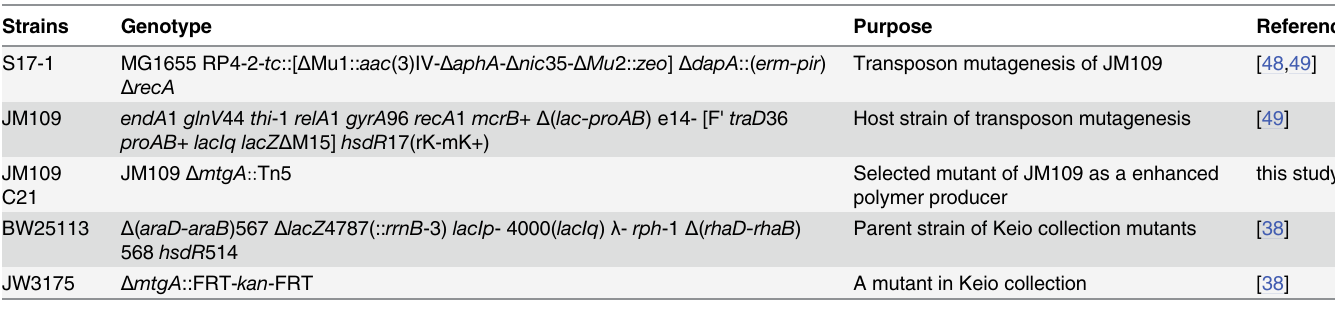
Table 1. E . coli strains used in this study.